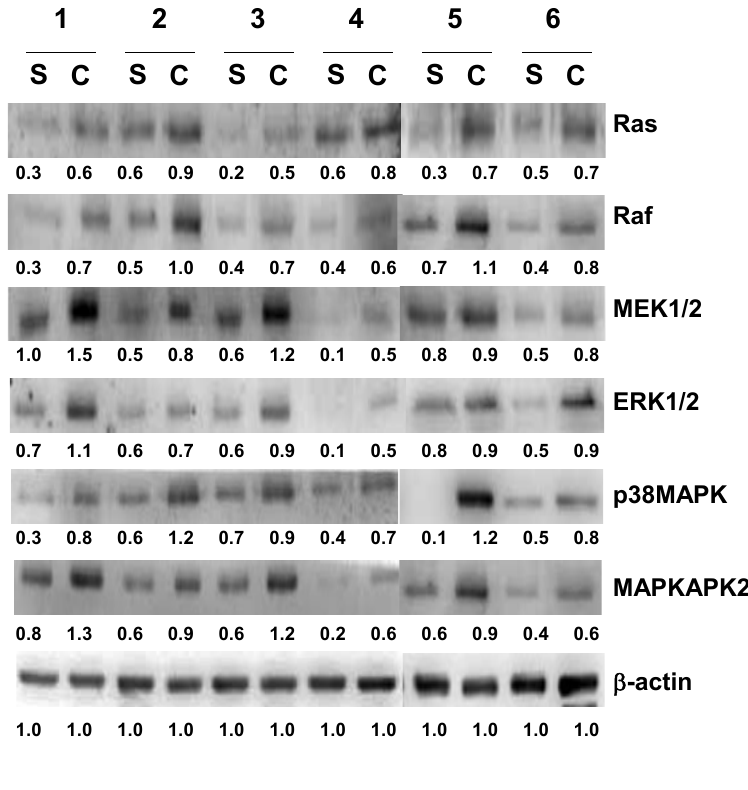
Figure 5. Validation of Ras, Raf, ERK1/2, MEK1/2, p38MAPK and MAPKAPK2 by Western blotting analysis. The tissues of cholesteatoma and retroauricular skin were from six individual patients. Cholesteatoma is presented by C, and retroauricular skin is presented by S. β -actin was used for